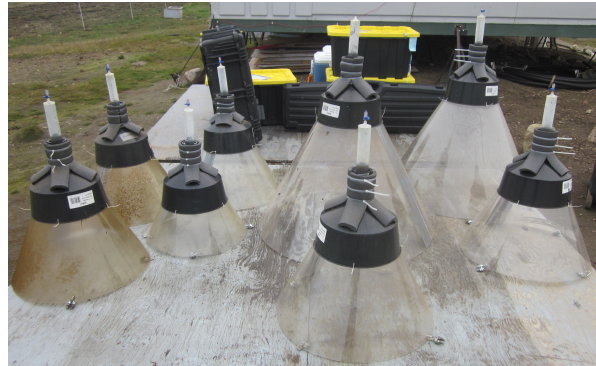
Figure A1. Picture of the homemade funnels deployed in ponds and lakes (photo taken in July 2014 just after their removal).